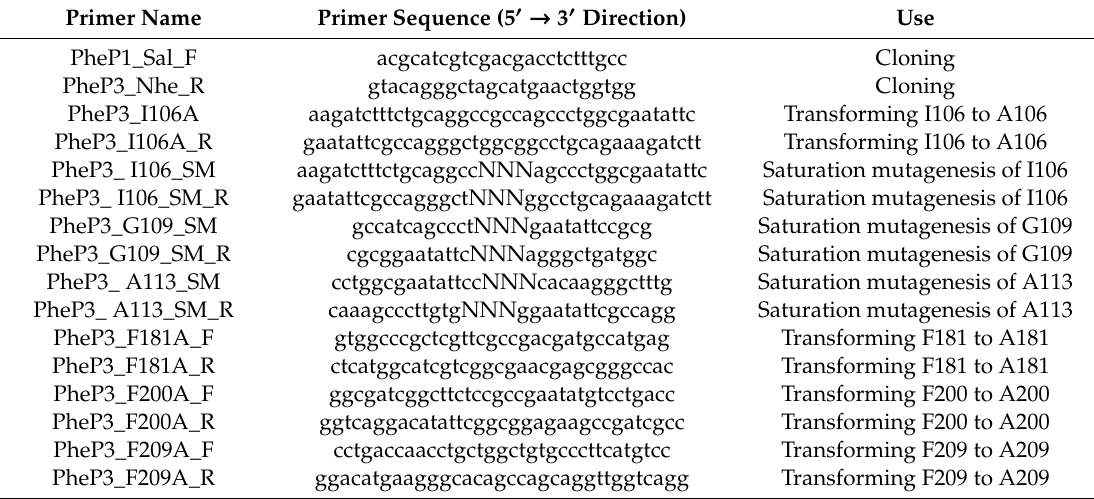
Table 2. DNA sequence of the primers.